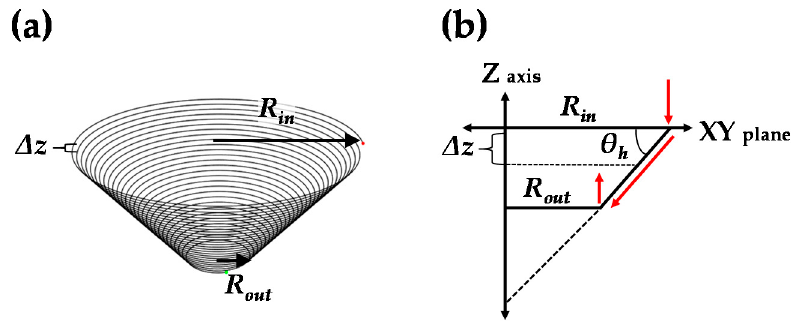
Figure 5. ( a ) Schematic figure of the tool path for circular cup shape and ( b ) sectional view.